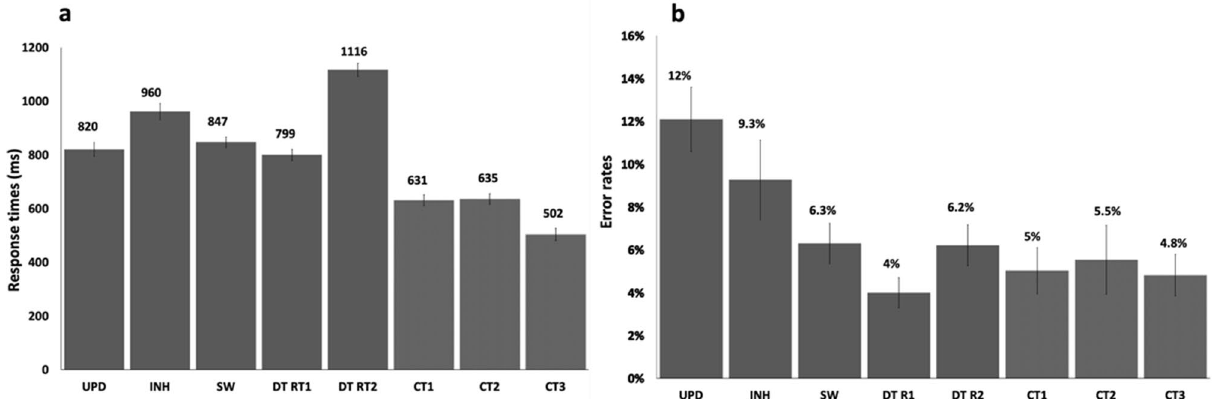
Figure 1. Mean RTs ( a ) and error rates ( b ) for each EF and control task. In the dual-task, the participants always had to respond first to the digits (CT1) and then to the words (CT2), so that dual-task costs were determined as DT response time of the first task (RT1) vs CT1 and DT RT of the second task (RT2) vs CT2. SW was compared with the average of CT1 and CT2. INH and UPD are both compared with CT3, respectively. Error bars denote standard error of the mean (SEM).